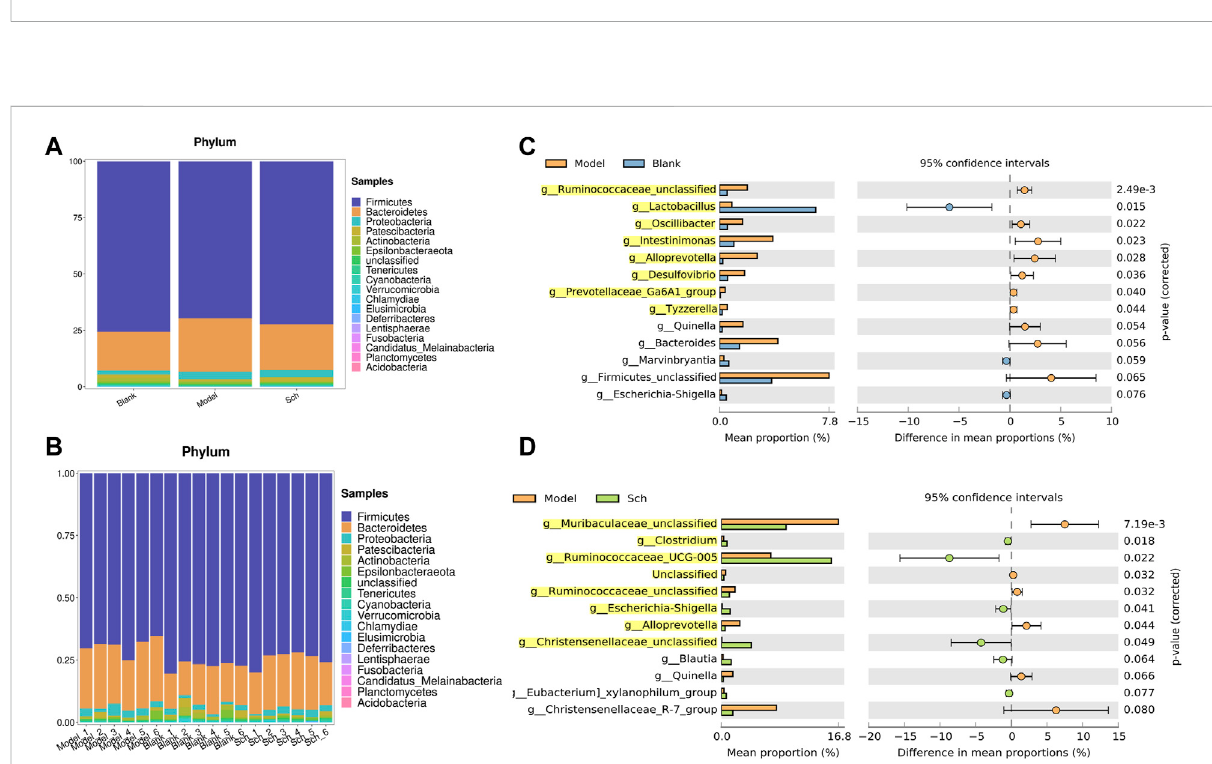
FIGURE 8 (A,B) Relative abundance of GM at the phylum level in the model group, blank group, and Sch group (%); (C) GM with signi fi cant differences between the genus level model group and the blank group; and (D) GM with signi fi cant differences between the genus level model group and the blank group. Analysis shows the relative abundance of microbial genus based on Welch ’ s test ( p ≤ 0.05). The colored circles represent 95% con fi dence intervals calculated using Welch ’ s inverted method. GM with signi fi cant differences ( p ≤ 0.05) is